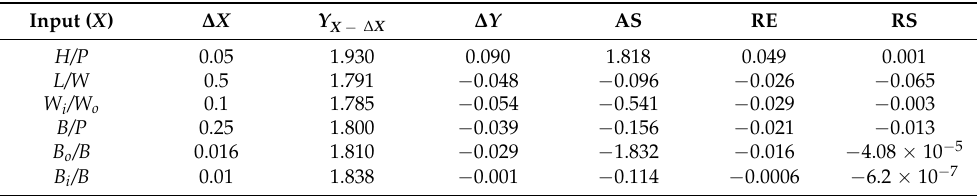
Table 8. Sensitivity and error analysis ( X is an input parameter, ∆ X is a 10% decrease in X , and ∆ Y is a change in the output ( C D